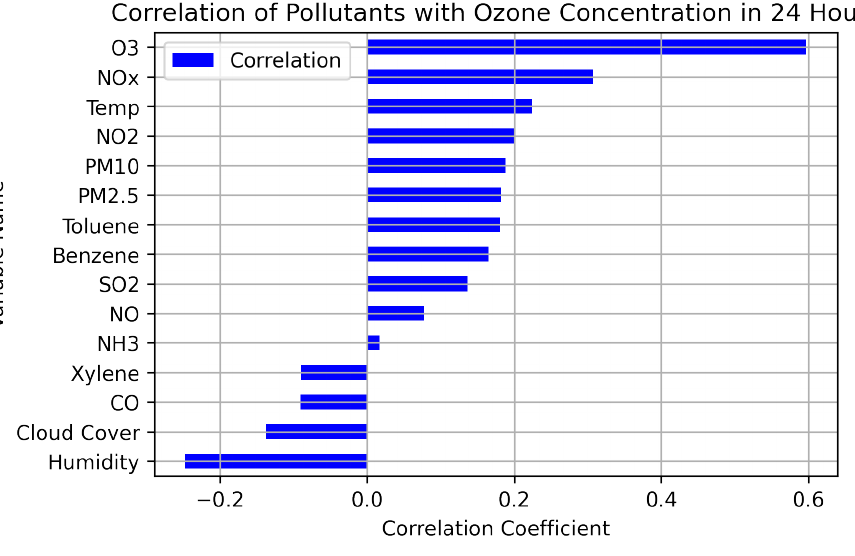
Figure 8. Accuracy of ozone forecast with varying lead time. Prediction skill drops from 0 to 10 h out, but then recovers out to 24 h. This makes it possible to forecast ozone 24 h in advance.